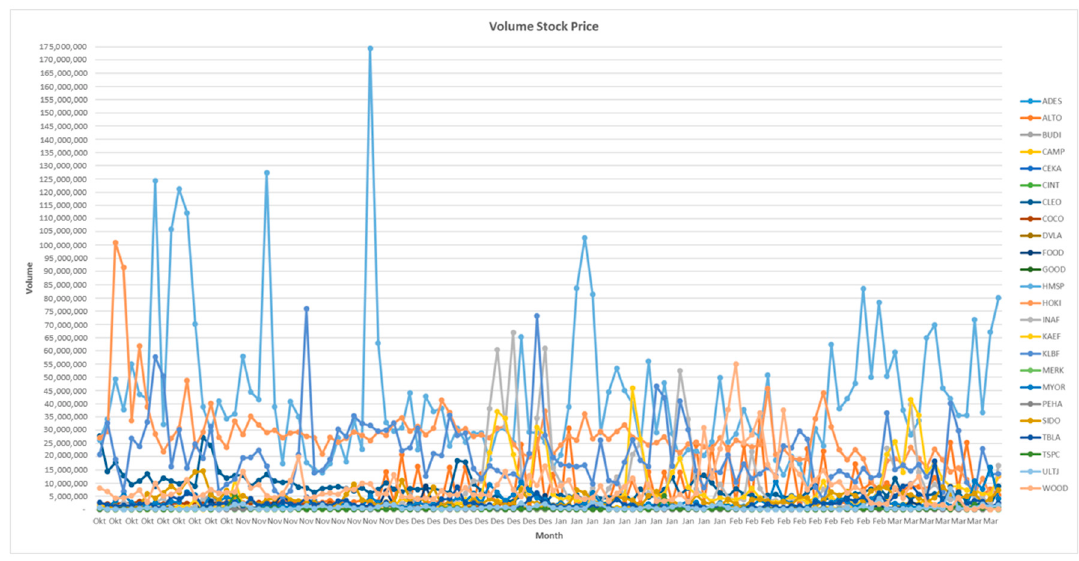
Figure 3. Volume stock price.